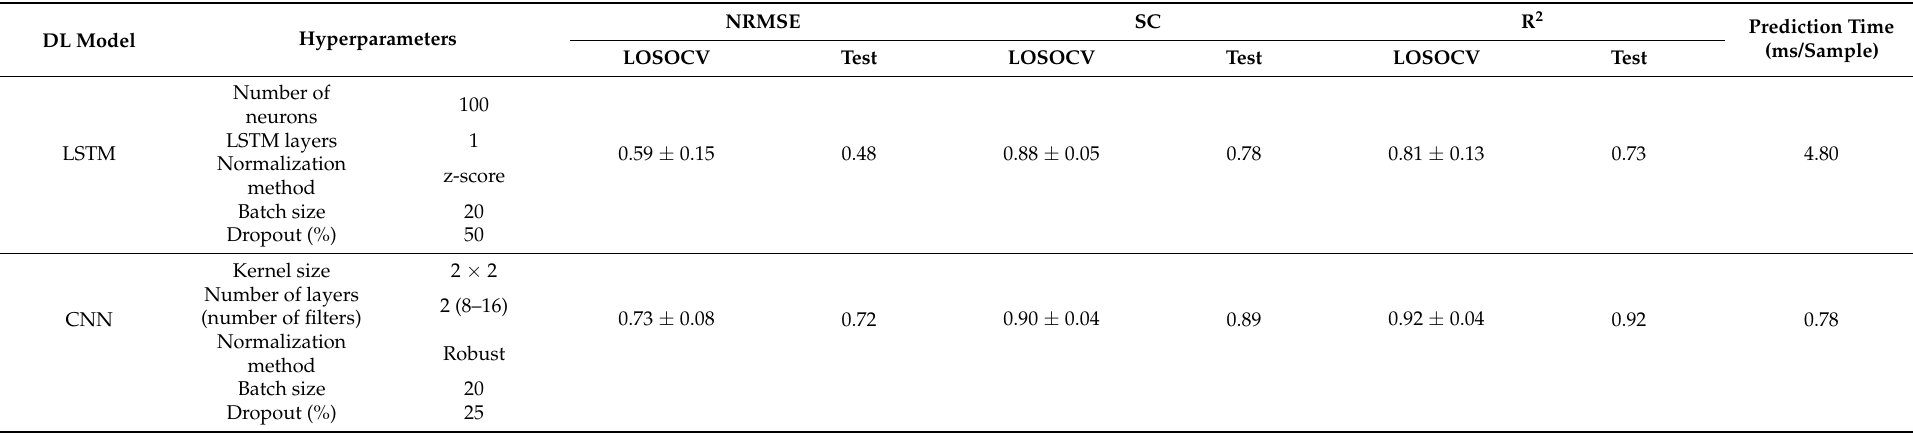
Table 3. NRMSE, SC, R 2 , and computational time results for both DL models without using EMG